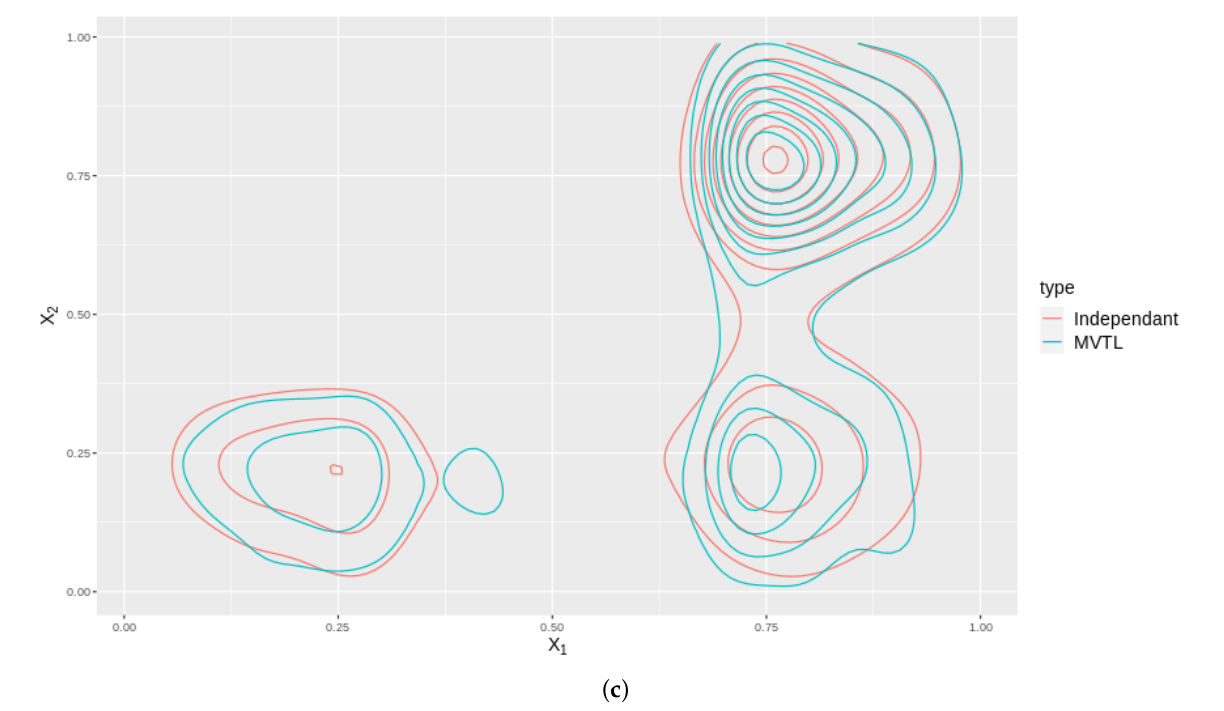
Figure 7. These subfigures are bivariate density plots for variables X 1 , X 2 and X 3 plotted against themselves in exhaustive pairs. The plots consider the cases when they independently generated (Red contours) and the case when they are generated using a copula (Blue contours). ( a ) Contour plot of X 1 against X 3 . ( b ) Contour plot of X 2 against X 3 . ( c ) Contour plot of X 1 against X 2